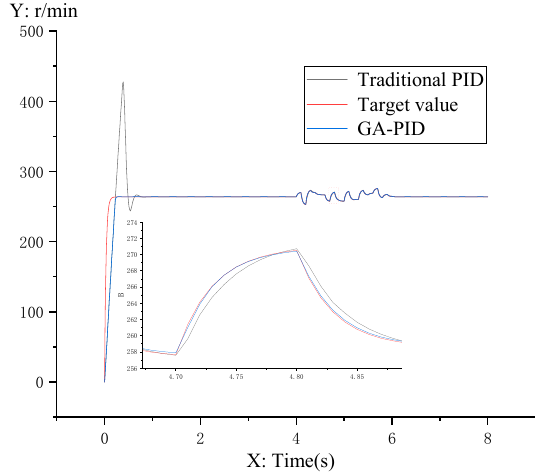
Figure 6. Rotation speed control under the single coal hardness. Table 3. Simulation data of rotation speed under the single coal hardness.